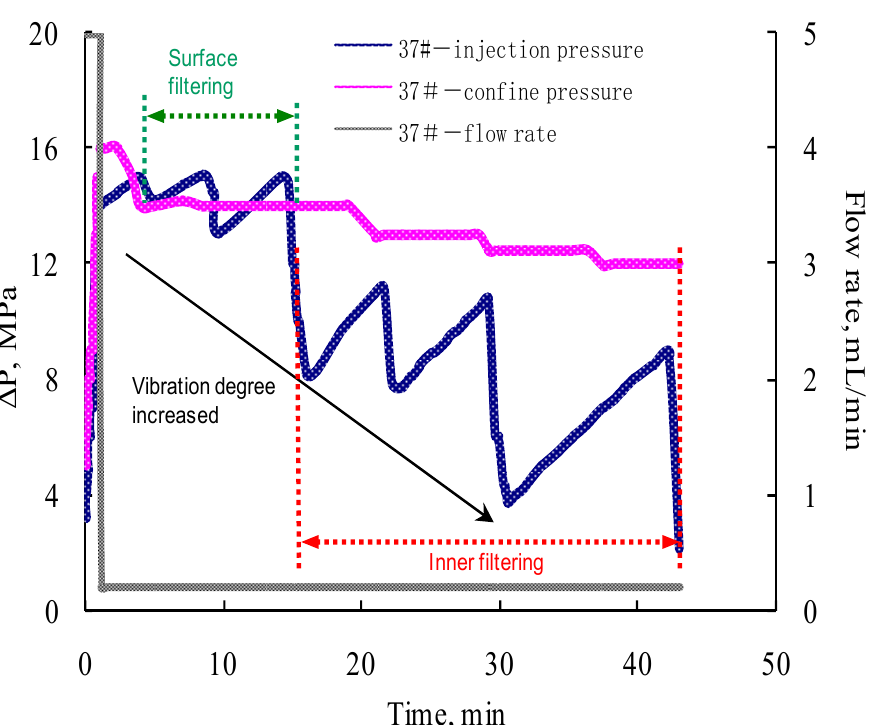
Figure 5. Pressure and flow rate versus time during the acid fracturing process of sample 37 (1.5 VES, 27% HCl).